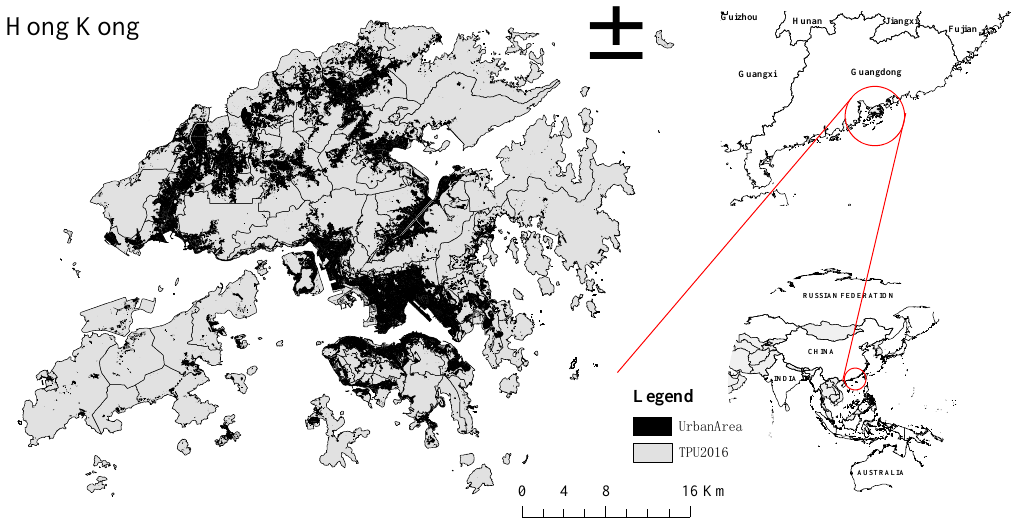
Figure 1. Hong Kong Special Administrative Region (SAR) of China.